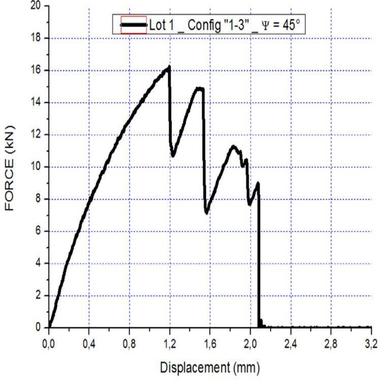
Typical force vs. displacement response of three-sheet spot weld assembly.